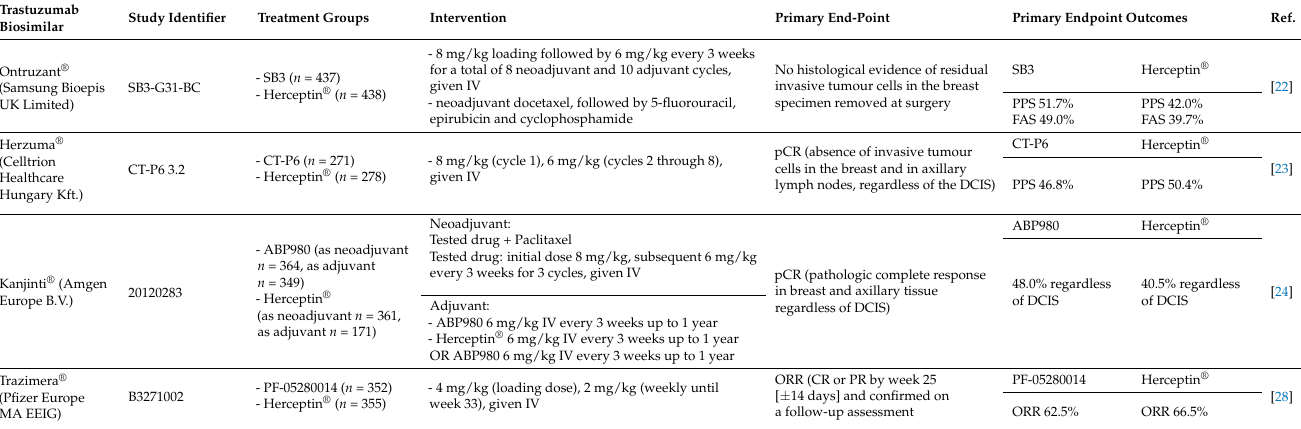
Table 3. Treatment groups, interventions and efficacy parameters of the clinical trials conducted for the EU-approval of trastuzumab